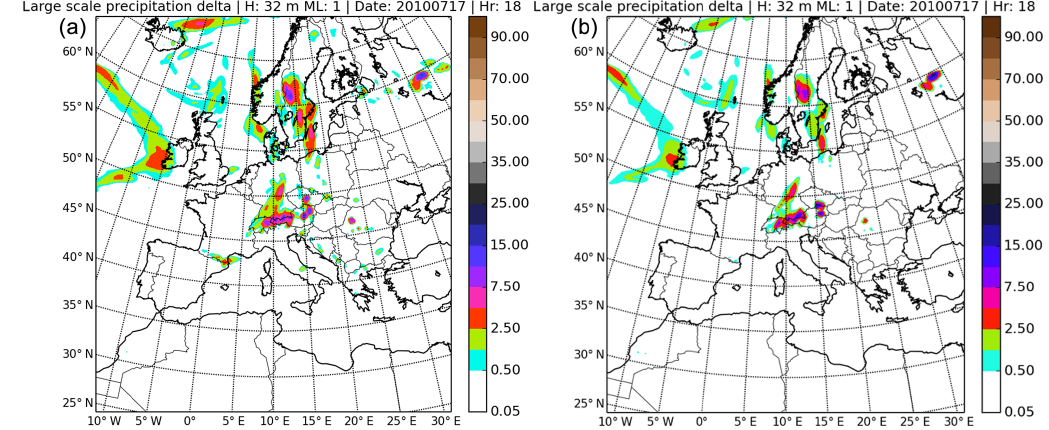
Figure 7. Accumulated (3h) precipitation patterns from Reference-HIRLAM (REF) and Enviro-HIRLAM with aerosol–cloud interactions (ENV) on 17 July 2010 at 18:00UTC: stratiform precipitation: (a) REF, (b)